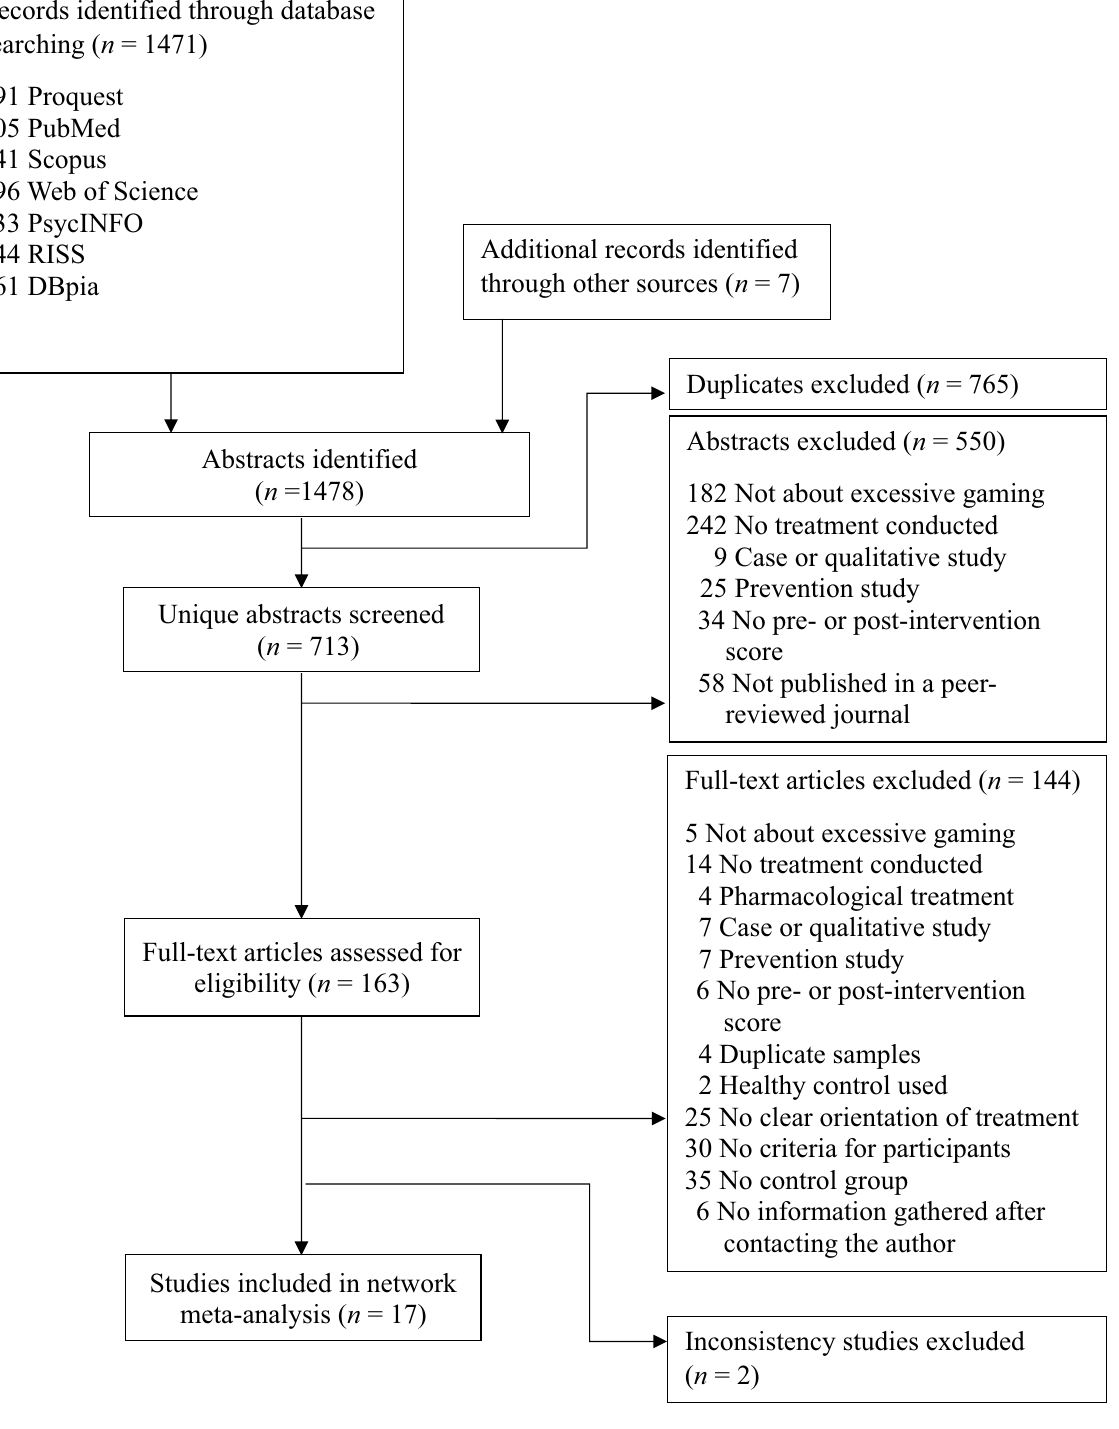
Figure 1. Flow diagram of the study selection